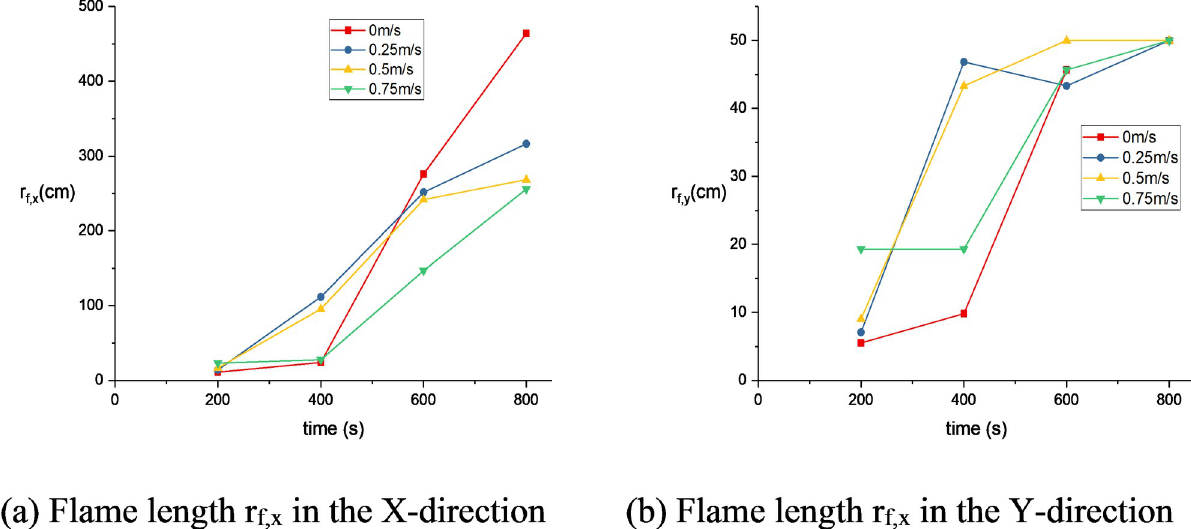
Fig 15. Flame lengths (r f ) underneath the ceiling in the x- and y-directions for different wind speeds.